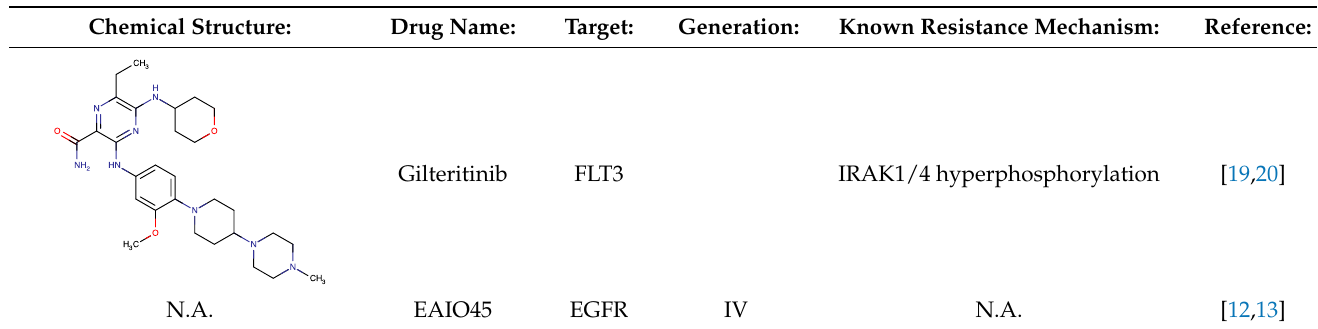
BTK: Bruton’s Tyrosine Kinase, PLCg2: Phospholipase Cgamma2, RAF: Rapidly Accelerated Fibrosarcoma, BRAF: Rapidly Accelerated Fibrosarcoma homolog B, CRAF: Rapidly, Accelerated Fibrosarcoma homolog C, EGFR: Epidermal growth factor receptor, NRAS: Neuroblastoma RAS viral oncogene homolog, KRAS: Kirsten rat sarcoma virus, NF1: Nuclear factor I, CUL3: Cullin 3, VEGFR-1: Vascular endothelial growth factor receptor 1, MCF2: MCF.2 cell line-derived transforming sequence, VAV1: vav guanine nucleotide exchange factor 1, SFK: Src family of Kinases, BOP1: Block Of Proliferation 1 Protein, ALK: Anaplastic Lymphoma Receptor Tyrosine Kinase, COT/TPL2: Cot (Cancer Osaka Thyroid)/Tumor progression locus 2, MEK: Mitogen-activated protein kinase, ERK: extracellular-signal-regulated kinase, HER2: human epidermal growth factor receptor 2, MET: mesenchymal epithelial transition factor, IRAk1/4: interleukin-1 receptor-associated kinase 1 and 4.